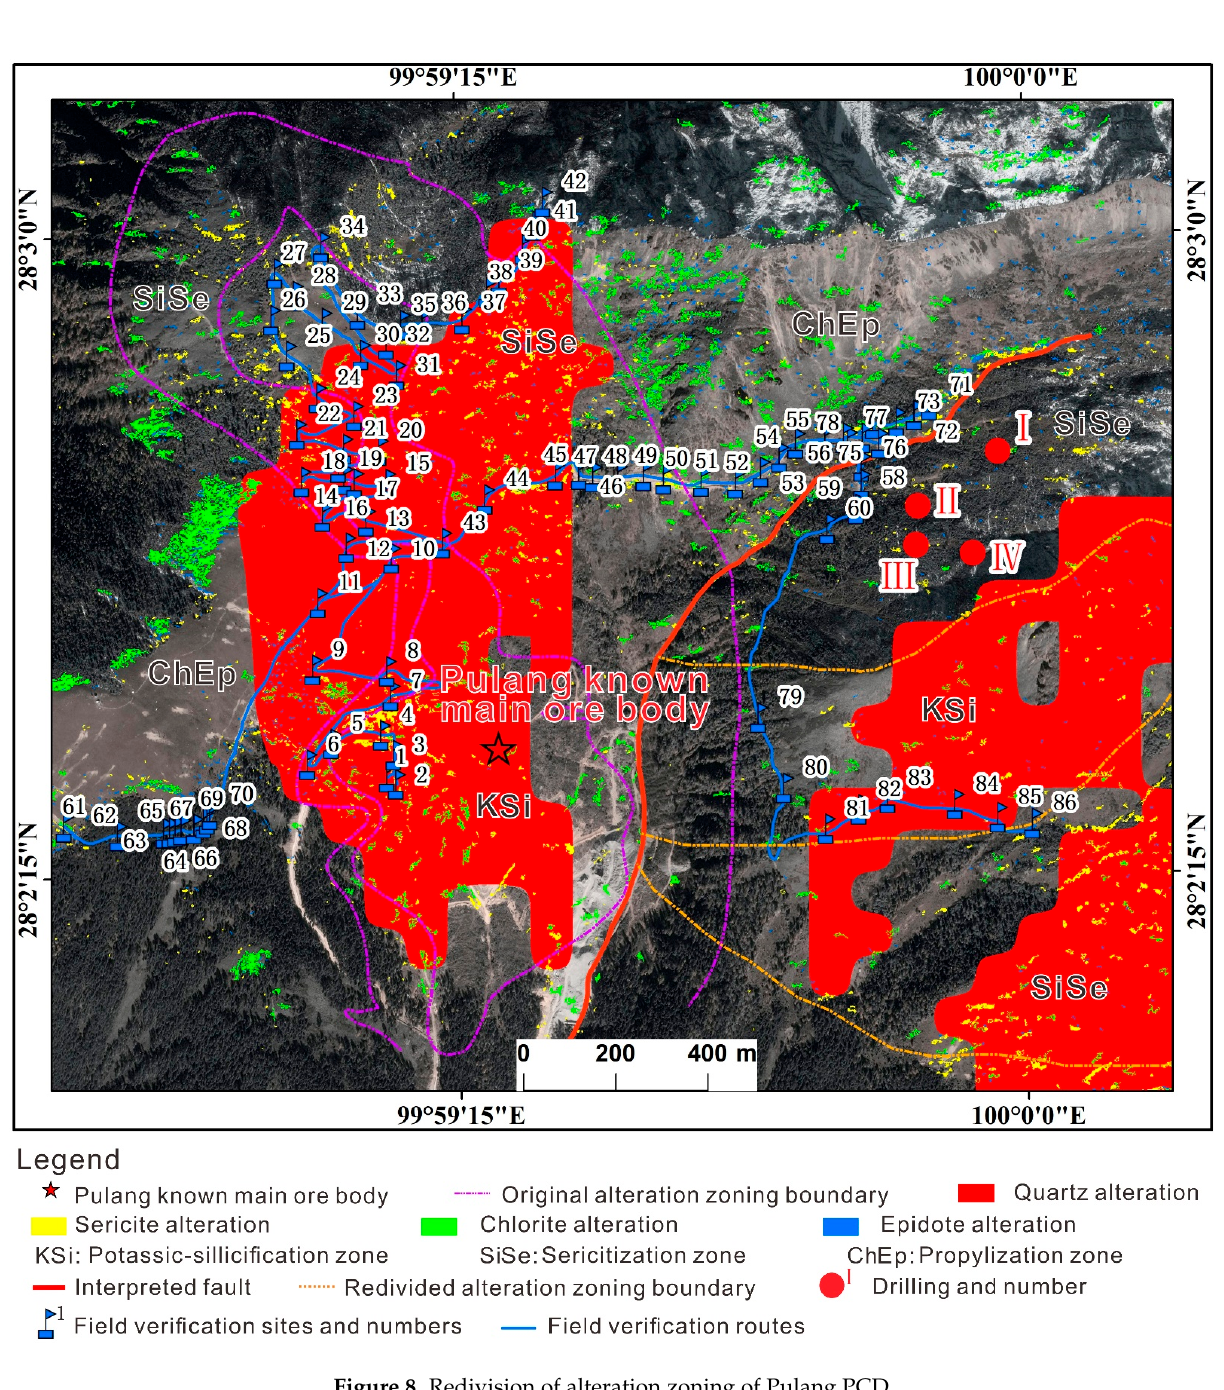
Figure 8. Redivision of alteration zoning of Pulang PCD.